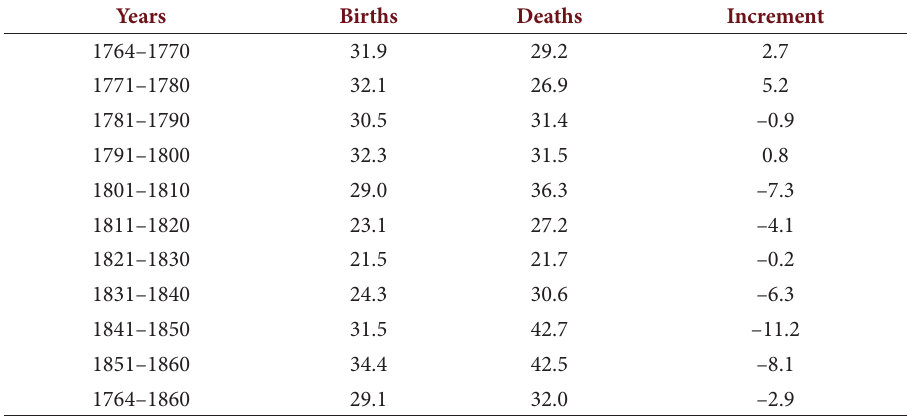
Table 9. Dynamics in natural population movement in St. Petersburg in 1764-1860, ‰ Years Births